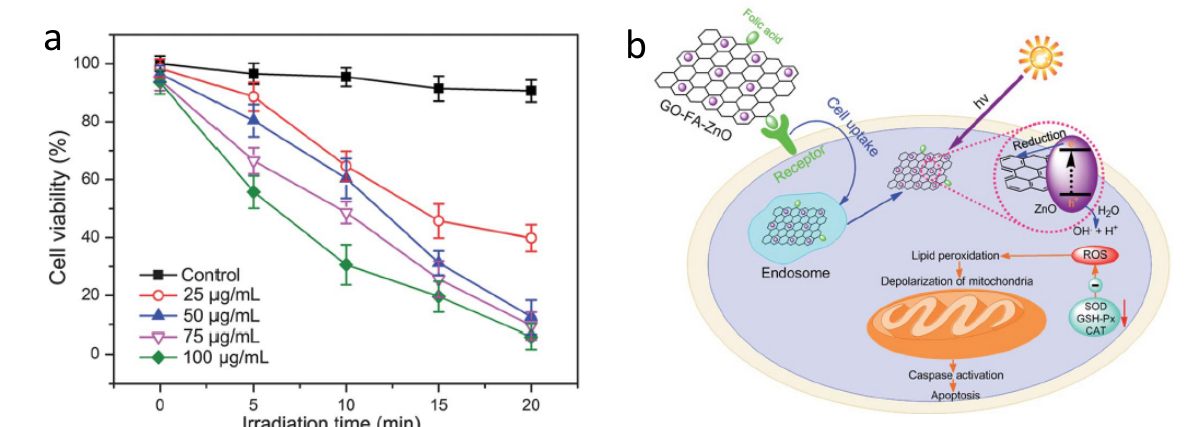
Figure 5. ( a ) Phototoxicity of GO–FA–ZnO. ( b ) Hypothetical mechanism of GO–FA–ZnO-induced PDT. Reprinted with permission from Ref. [96]. Copyright 2013 Royal Society of Chemistry.